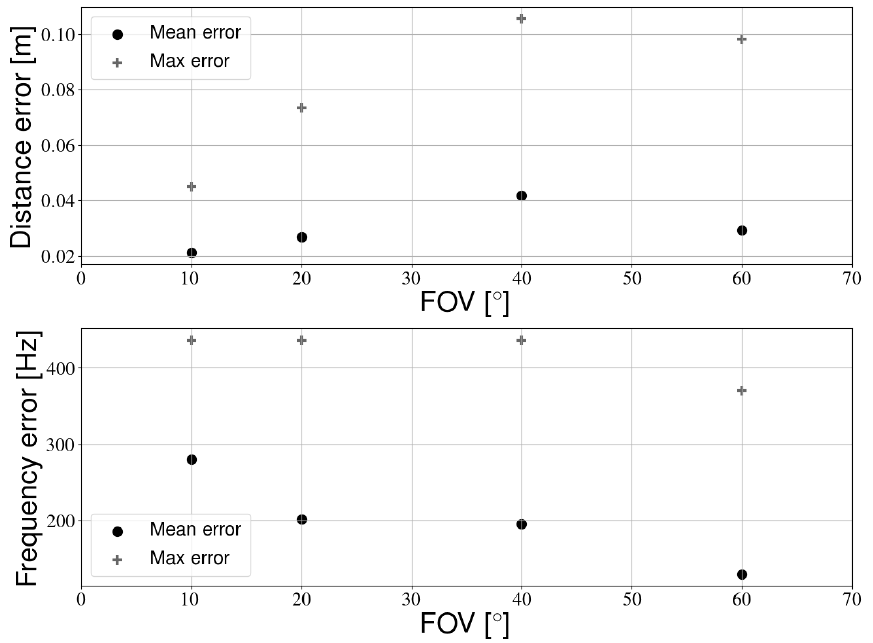
Figure 14. Top: positioning accuracy as a function of the camera FOV. Bottom: frequency accuracy as a function of the camera